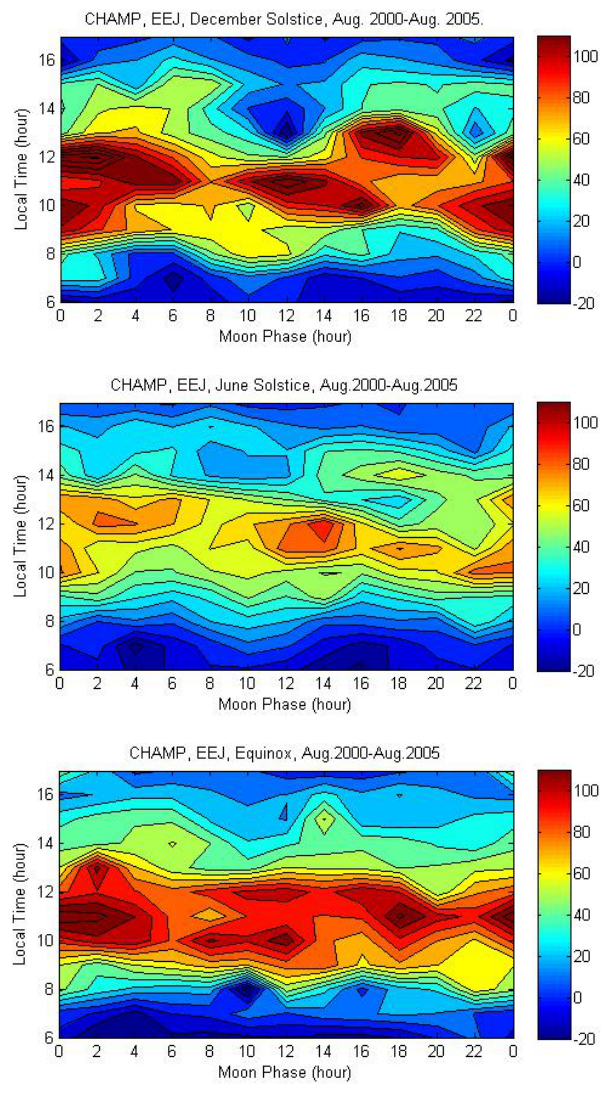
Fig. 4. The same as Fig. 2, but separately for the seasons around December solstice, June solstice and equinoxes.